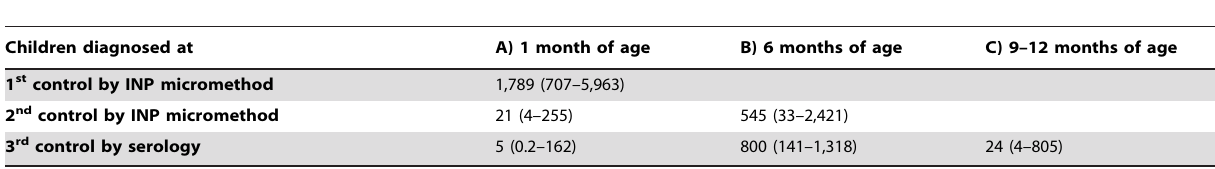
Table 1. Quantitative parasitemia in T. cruzi congenitally infected children.